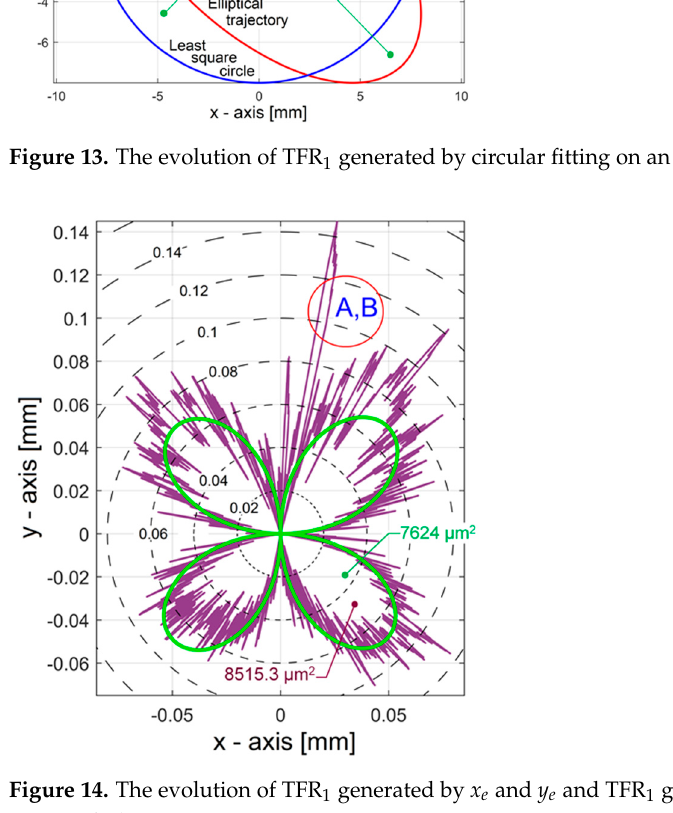
Figure 15. The evolutions of TFR 1a.